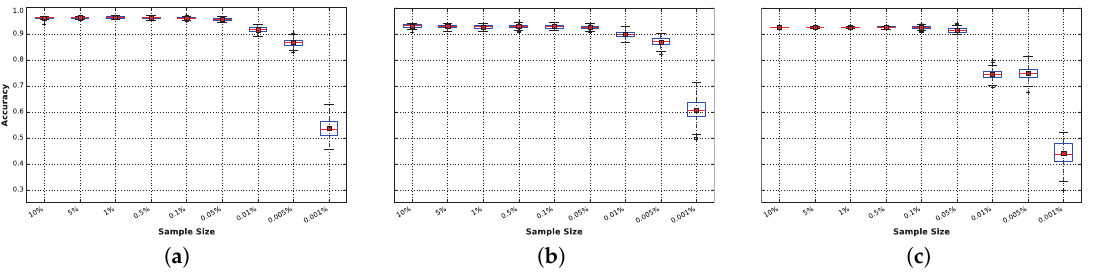
Figure 8. How training sample size affects the accuracy distributions, aggregated for all subjects, for the high-performing classifiers. ( a ) Extra trees; ( b ) DNN 1L; ( c )